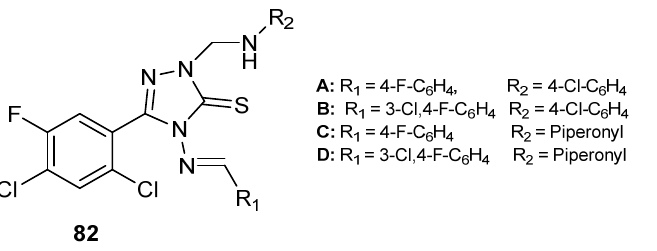
Figure 9. Antifungal Schiff bases derived from 2,4-dichloro-5-fluorophenyl